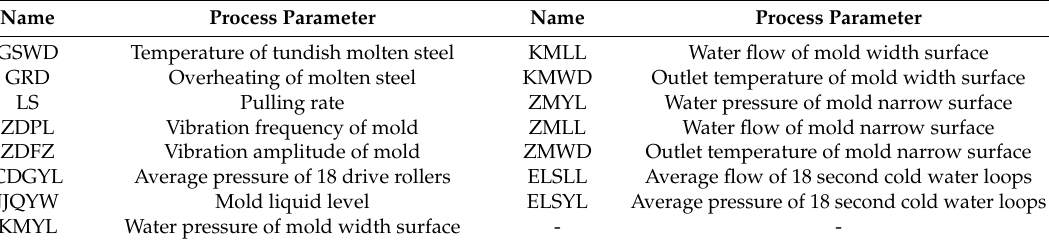
Table 1. Process parameter names and